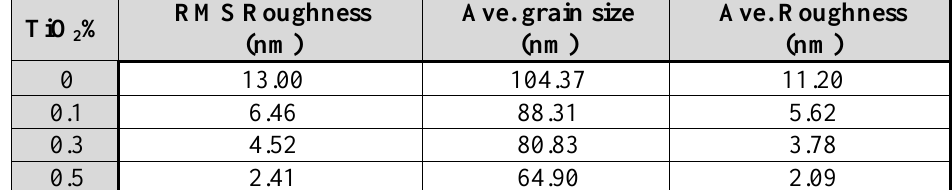
Fig. 1: AFM image for (V 0.3, 0.5). Table 1: Average grain size and average roughness for (V TiO content at 2